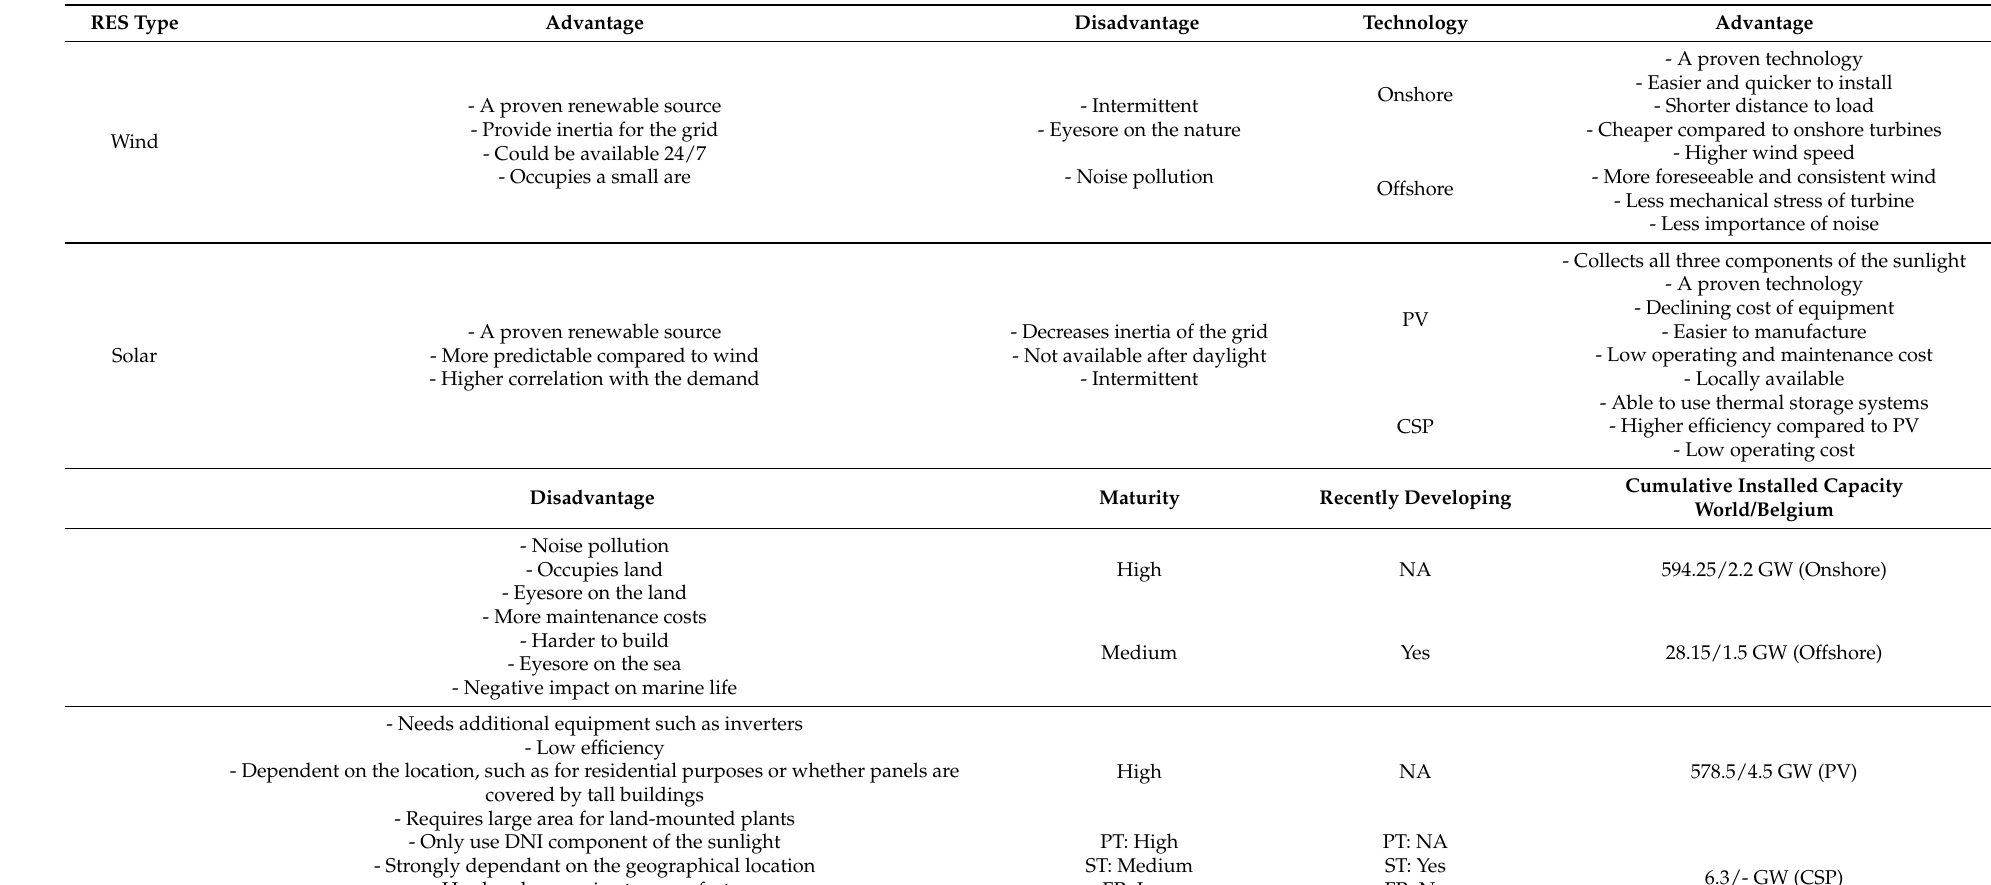
Table 7. Comparison of solar, wind and their related